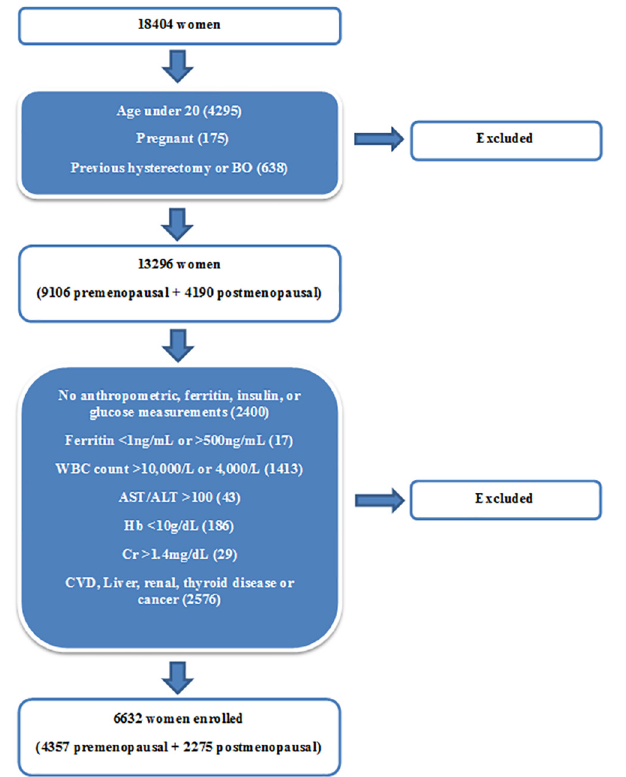
Fig 1. Flow chart of participant